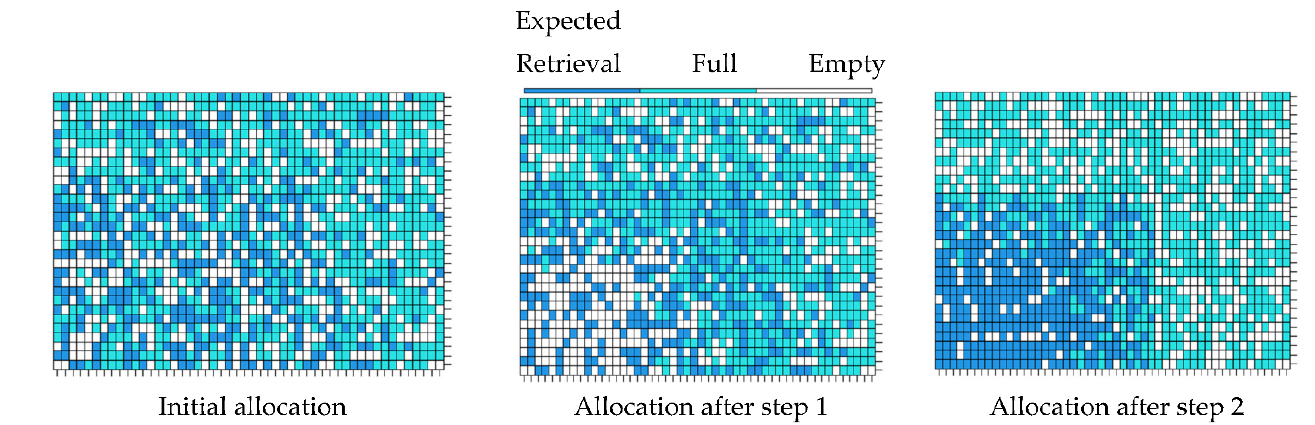
Figure 7. The effect of reallocations steps on load positions in the rack.